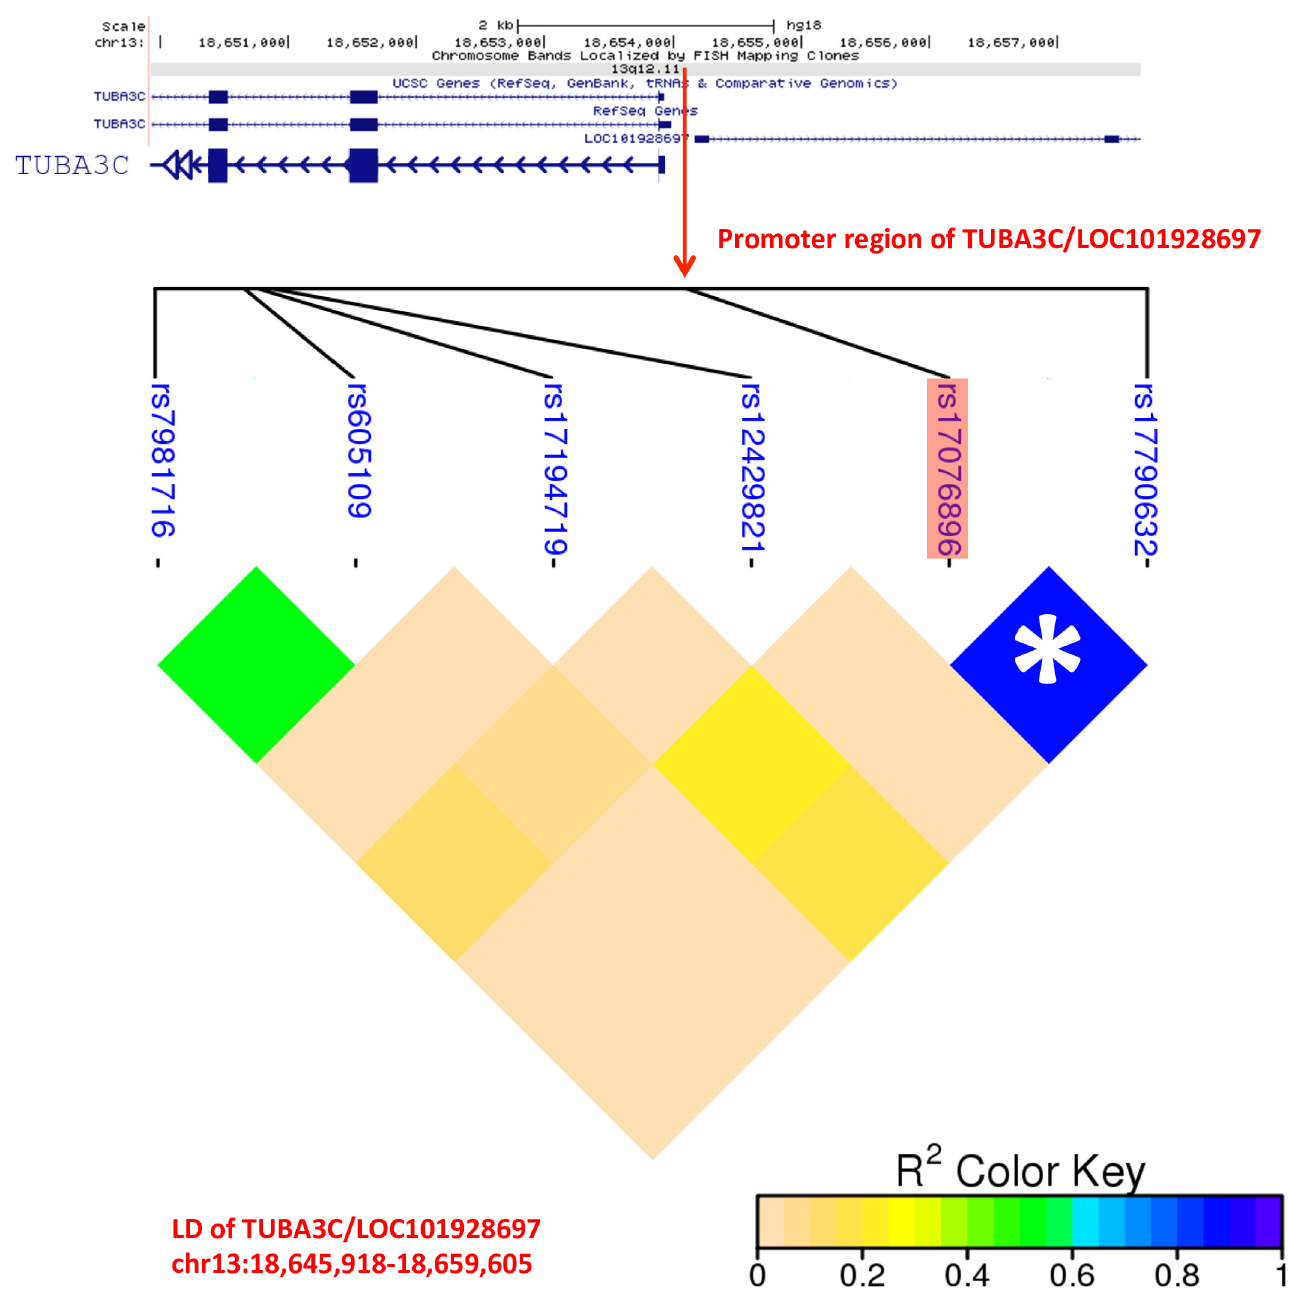
Fig 3. Linkage disequilibrium plot of a region containing all SNPs of TUBA3C and LOC101928697. The significant genetic variant of rs17076896 ( P = 8.04 × 10 − 9; OR = 21.03) is located in the shared promoter region between TUBA3C and LOC101928697, which showed a high linkage disequilibrium (r 2 = 0.90) with another down-stream SNP, rs17790632, in